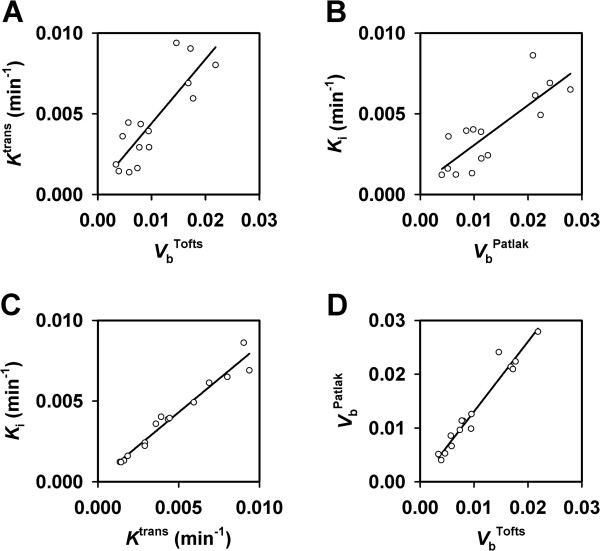
DCE-MRI data for CK-160 cervical carcinoma xenografts imaged with gadomelitol as contrast agent. (A) Median Ktransversus median VbTofts. (B) Median Kiversus median VbPatlak. (C) Median Kiversus median Ktrans. (D) Median VbPatlakversus median VbTofts. The points represent single tumors. The curves were fitted to the data by linear regression analysis.